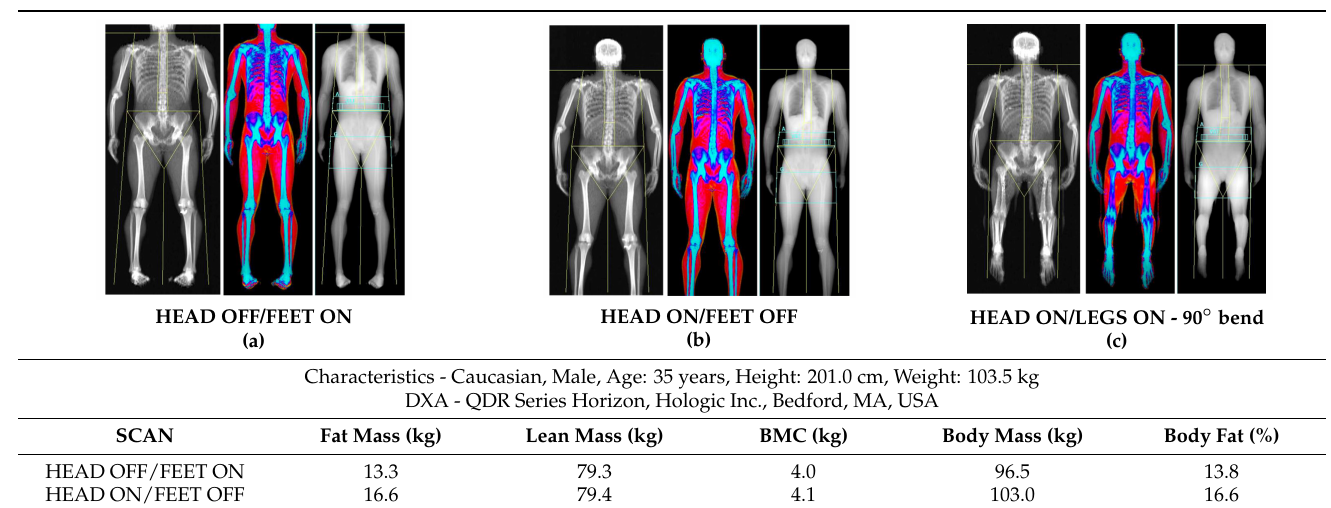
Table 3. An example of failure to fit different athletic body types within the confinements of the DXA bed and how this affects results: (a) head on, feet off; (b) head off, feet on; (c) head on, feet on with 90 ◦ bend of the knee.